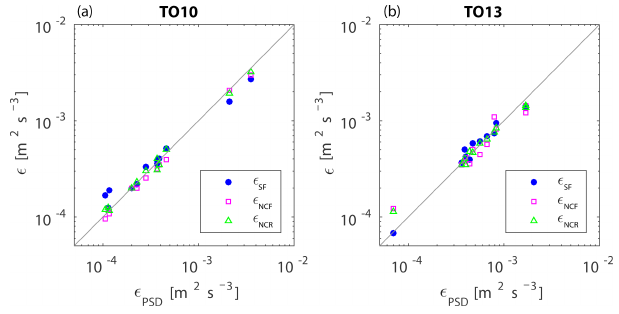
Figure 12. Dissipation rate of the kinetic energy estimated from the structure function method (cid:15) SF , zero crossings of successively fil- tered signals (cid:15) NCF and zero crossings of signals with recovered part of the spectrum (cid:15) NCR as a function of (cid:15) PSD (from the power spectra method). Each point represents an estimate from a single horizontal segment of flight in the atmospheric boundary layer. (a) Flight 10; (b) flight